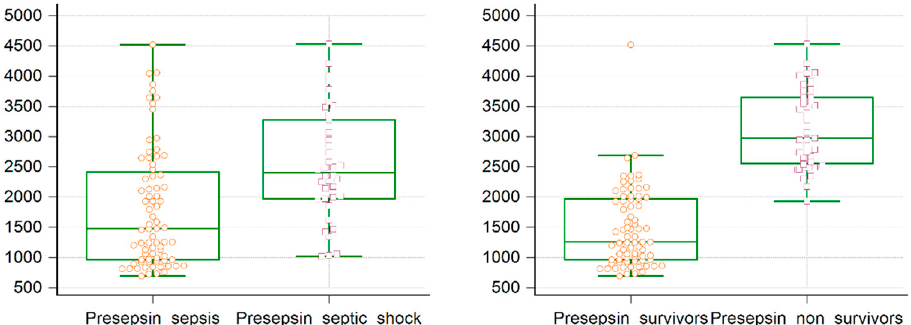
Figure 1. Presepsin box-and-whisker plot for patients with sepsis versus septic shock and survivors versus non survivors. Median values, 25/75 quartiles box, and lowest and highest values, as well as individual patient markers, are represented.